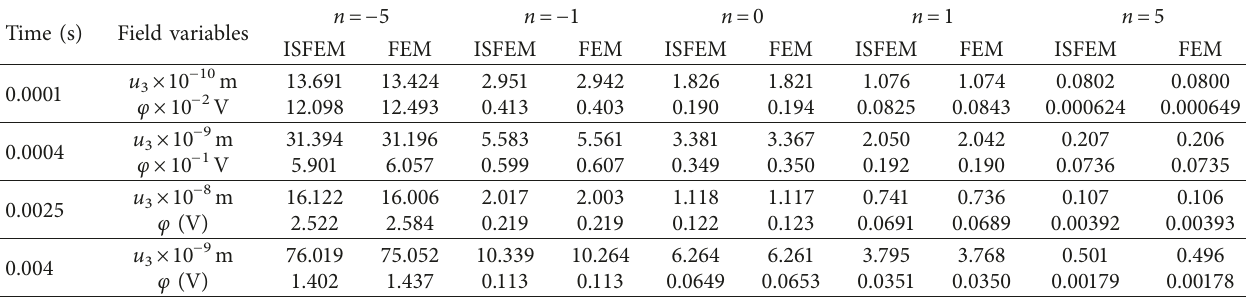
Table 3: Displacement u 3 and electrical potential φ at the loading point with the gradient parameter n based on PZT-5H.